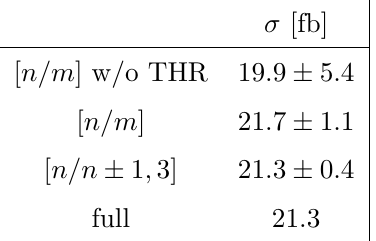
Table 1 . Numbers for the total LO cross section and standard deviation from the construction of 100 Pad(cid:19)e